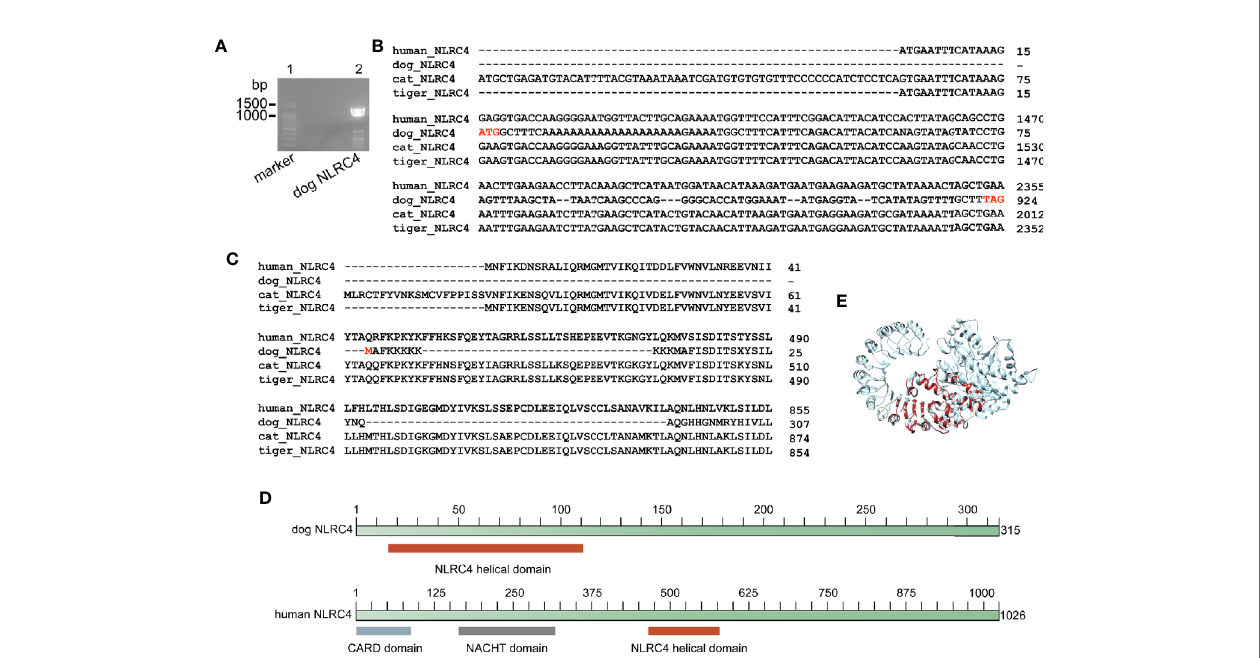
FIGURE 4 | Dog NLRC4 is a truncated protein without CARD domain and NACHT domain. (A) PCR ampli fi cation of dog NLRC4 from MDCK cell cDNA. Lane 1, marker of 100bp ladder. Lane 2, band of dog NLRC4. (B) Alignment of NLRC4 nucleotide sequences from humans, dogs, cats and tigers. (C) Alignment of NLRC4 protein sequences from humans, dogs, cats and tigers. (D) Diagram of NLRC4 domains from humans and dogs. (E) Super impose of NLRC4 tertiary structure from humans and dogs. Human NLRC4 and dog NLRC4 are in orange red and grey,